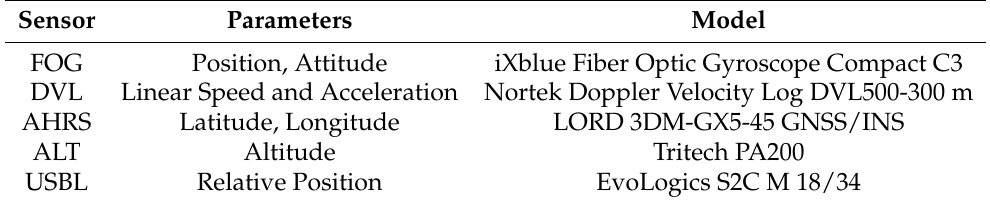
Table 1. Instruments for positioning of the UUV